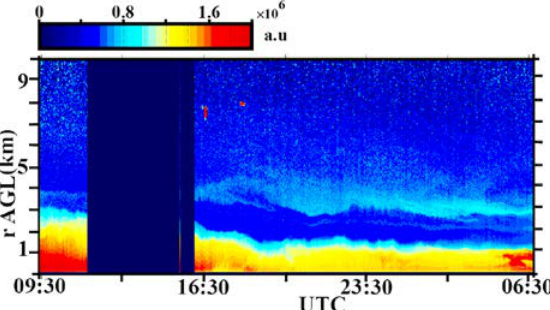
Figure 4 Time-height series of lidar attenuated back- scatter profile recorded in Zanjan at 1064 nm between 09:30 UTC on 07 April 2013 and 06:30 UTC on 08 April 2013.